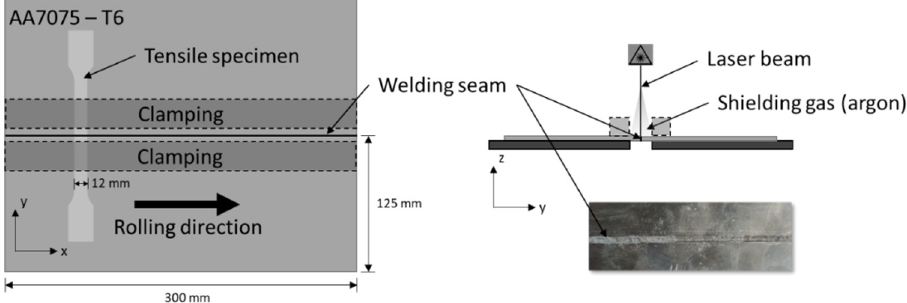
Figure 2. Schematic illustration of the experimental setup.